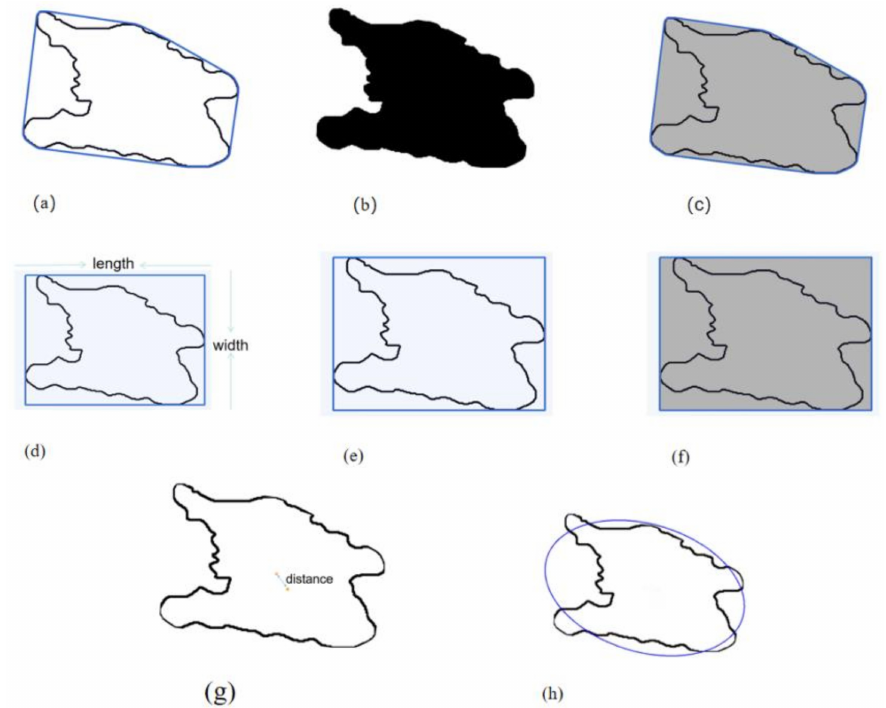
Figure 2. Visual depiction of morphological features. ( a ) Convexity, ( b ) Area of breast tumor, ( c ) area of convex hull, ( d ) elongation, ( e ) the smallest rectangular box, ( f ) area of box, ( g ) center distance, ( h ) Eeliptical